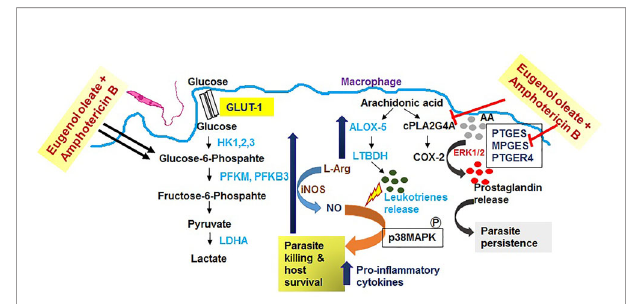
FIGURE 6 | Schematic diagram of the possible mechanism of combination therapy with eugenol oleate and amphotericin